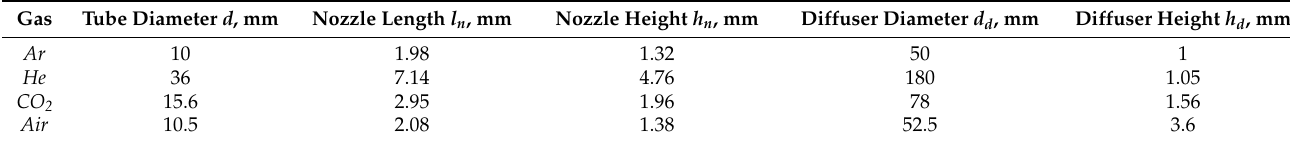
Table 2. Geometric parameters of investigated SVT.